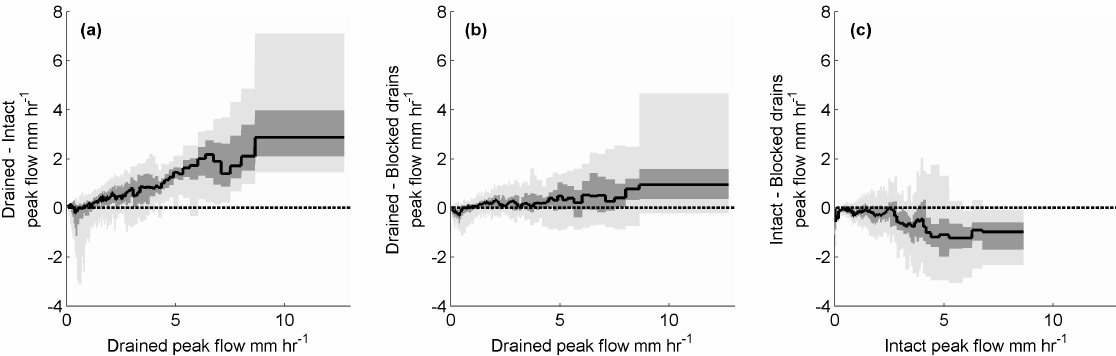
Fig. 2. Schematic of numerical representation of drained (a) and blocked drain (b) hillslope, demonstrating the concepts of soil sections and soil slices and the location of repeated fluxes.